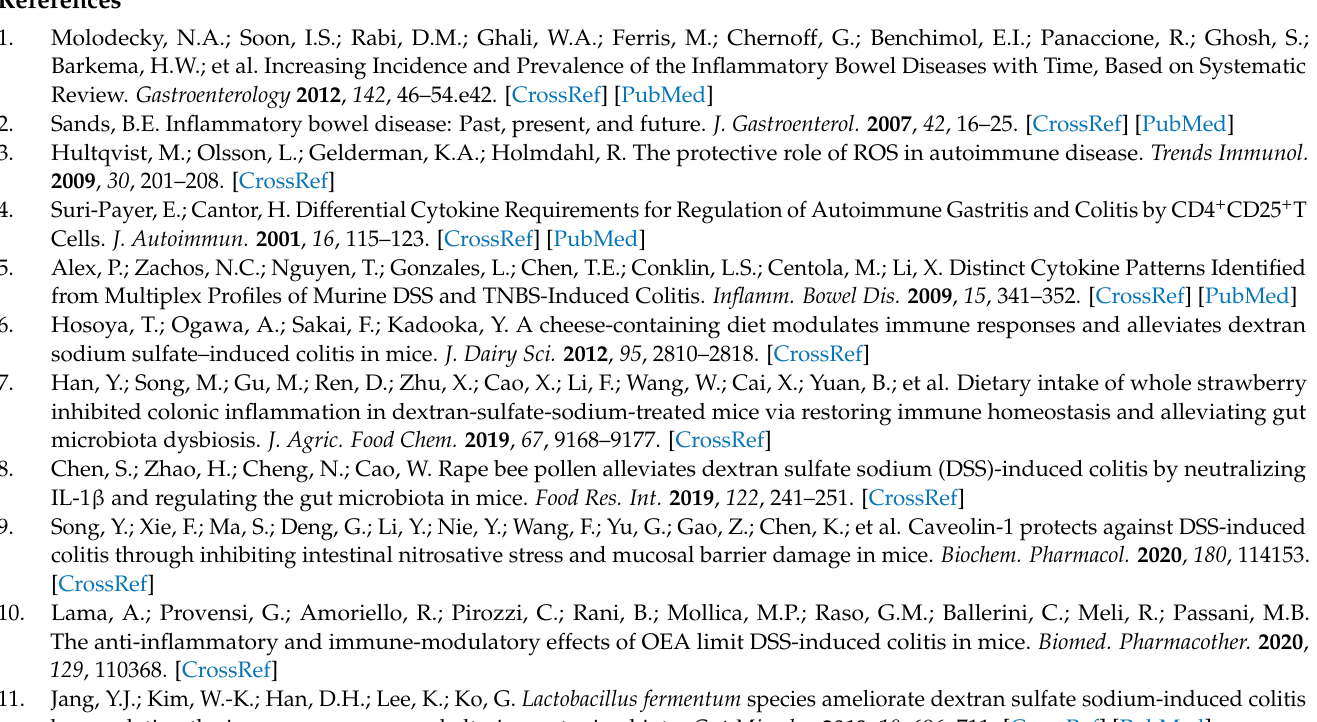
the six main phenolic compounds in FBPE. Figure S4: Representative images showing flow cytometry of T cell subsets in different groups of splenocytes. Table S1: Phenolic compounds of